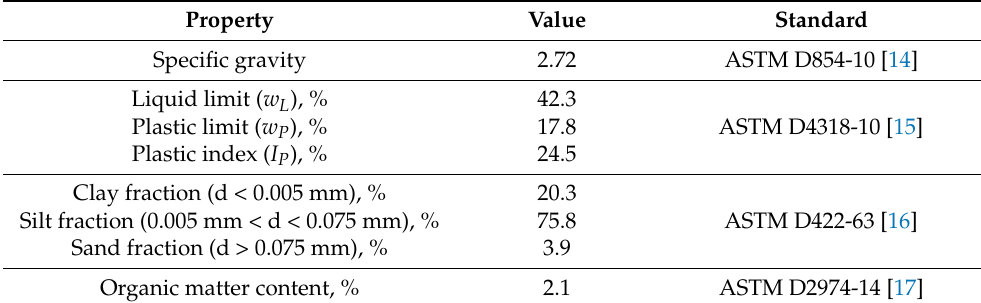
Table 1. Physical characteristics of dredged